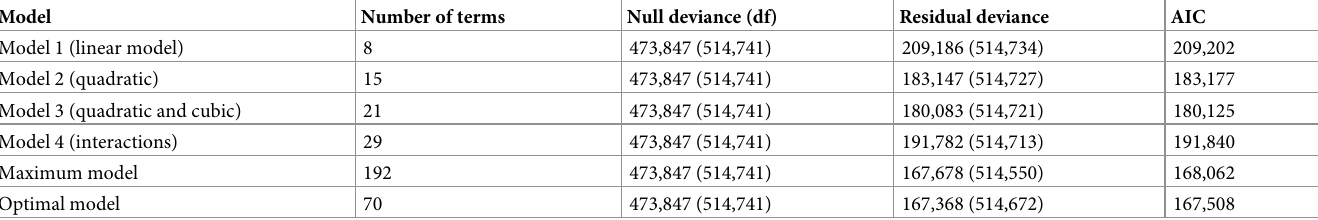
Table 2. Derivation of the optimal regression model.